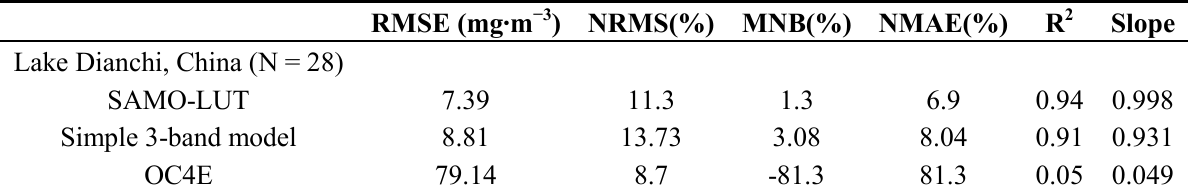
Table 2. Performance of the SAMO-LUT, Simple 3-band Model and OC4E for the estimation of Chl- a in Lake Dianchi, China.